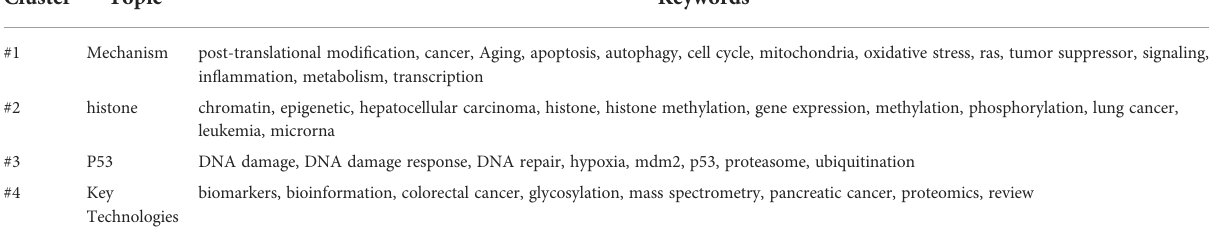
TABLE 4 Clustering of keywords for the study of PTMs in cancer fi eld. Cluster